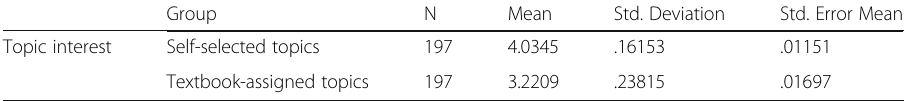
Table 9 The Mean Values of The Learner ’ s Perception of the Textbook-Assigned Topics and Self- Selected Topics Regarding the Topic of Interest Group